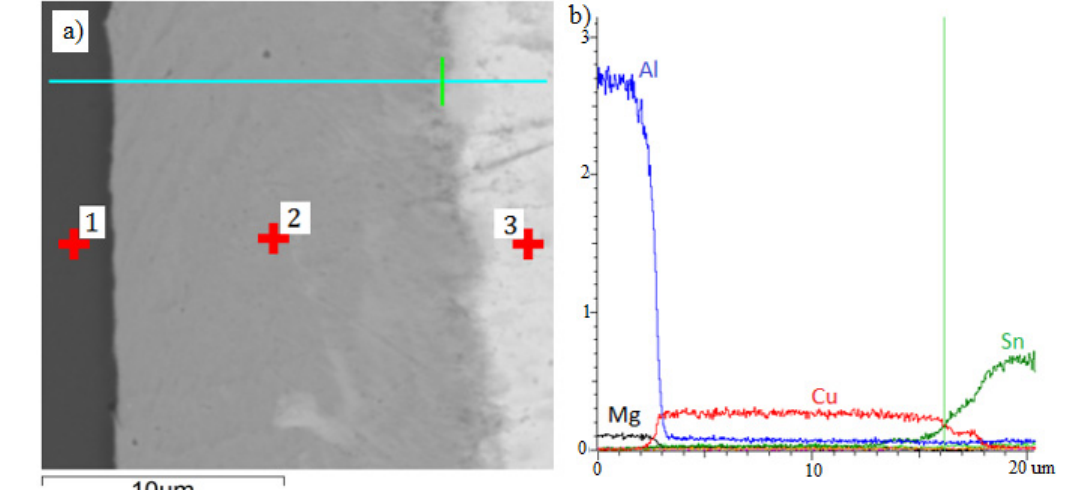
Figure 6. BSE (Back Scattered Electrons) image of transition zone ( a ) and linear EDS analysis of soldered joint made via Cu-Cr interlayer ( b ): 1—substrate (aluminum 7075), 2—Cu-Cr interlayer, 3—solder.